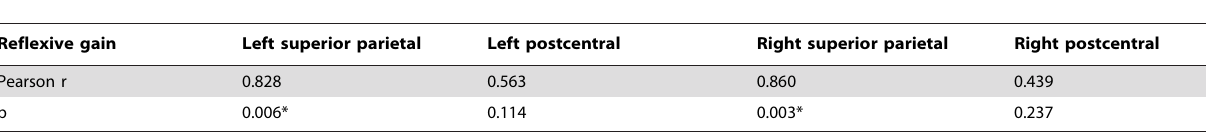
Table 5. Correlations of reflexive gain with parietal areas containing the PEF.